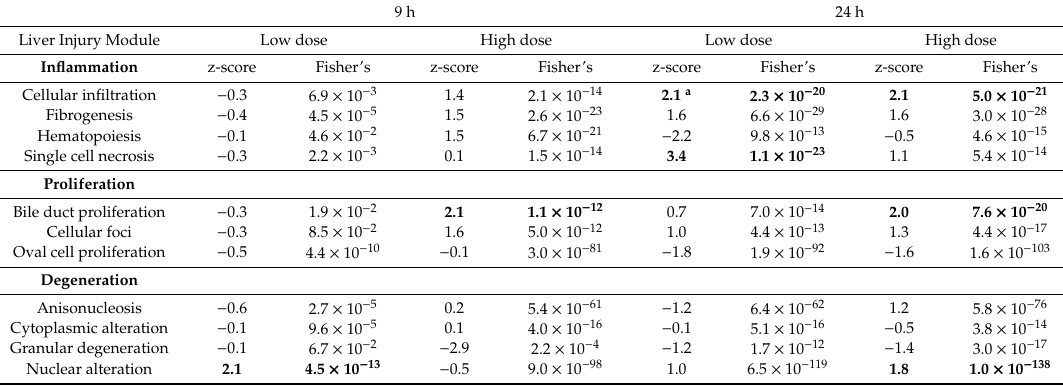
Table 2. Activation of kidney-injury modules in human renal tubular epithelial cells ( in vitro ) 9 and 24 h after exposure to thioacetamide-S-oxide (low: 0.25 mM; high: 1.0 mM). 9h Lowdose Highdose Highdose z-score −